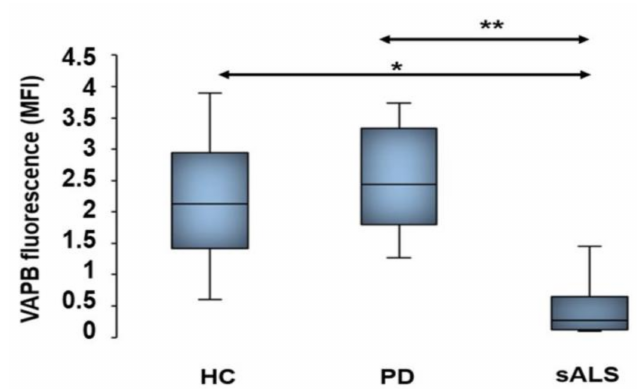
Figure 5. FCAs performed with a monoclonal antibody against VAPB. The graph shows a statistically significant decreased level of VAPB fluorescence detection in sALS patients compared to in PD patients and HCs. On the contrary, VAPB fluorescence signals in HCs and PD patients did not present significant di ff erences. The data are expressed as MFIs in all patients and controls analyzed. * p < 0.05; ** p < 0.005.